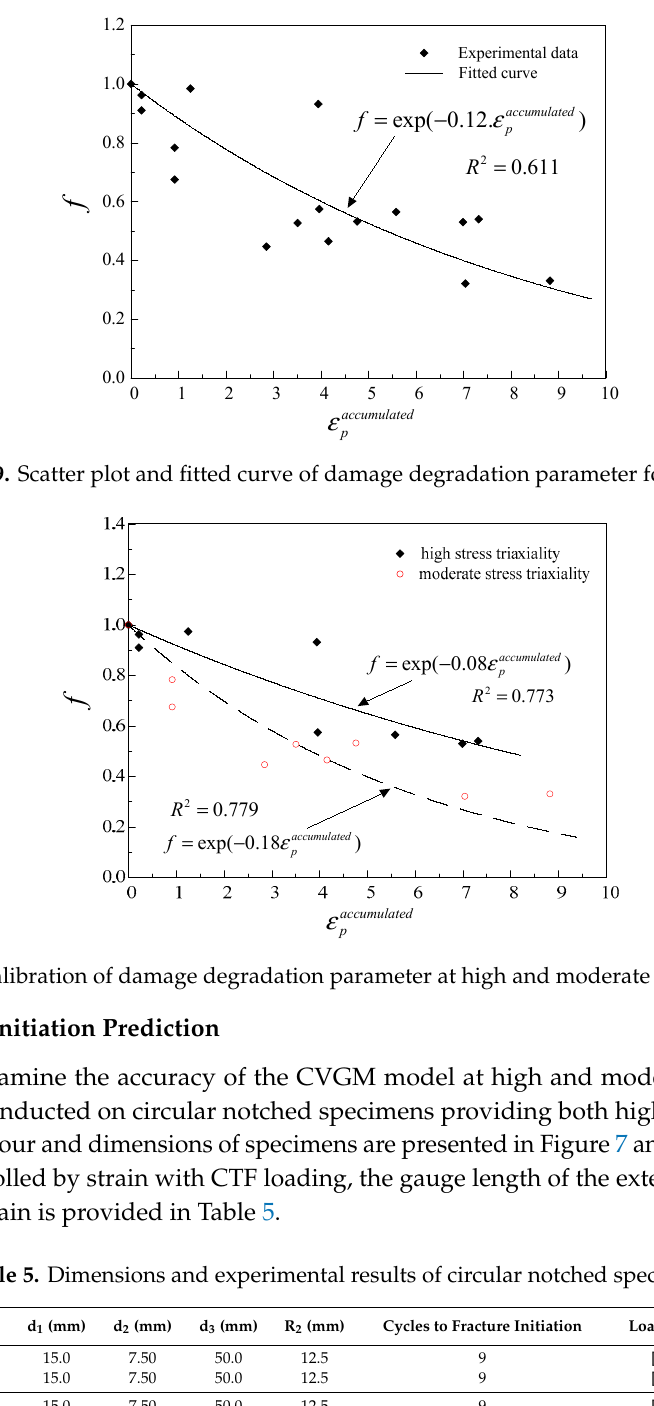
10 of 17 ( i ) Figure 8. Comparison of force-displacement of specimens obtained by tests and FEA: ( a ) BMC-1; ( b ) BMC-3; ( c ) BMC-5; ( d ) BMC-7; ( e ) BMC-9; ( f ) BMC-11; ( g ) BMC-13; ( h ) BMC-15; ( i ) BMC-17. The